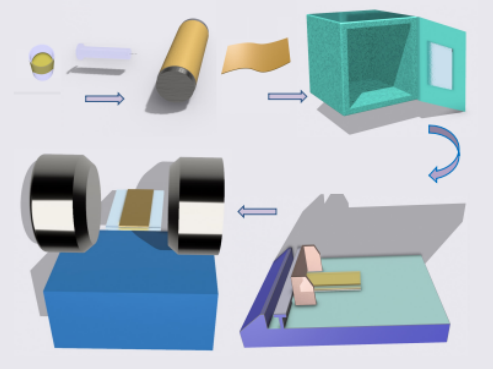
Figure 2. Preparation process of ( La 0.14 Ce 0.14 Mn 0.14 Zr 0.14 Cu 0.14 Ca 0.14 Ni 0.14 ) Fe 2 O 4 /PVDF